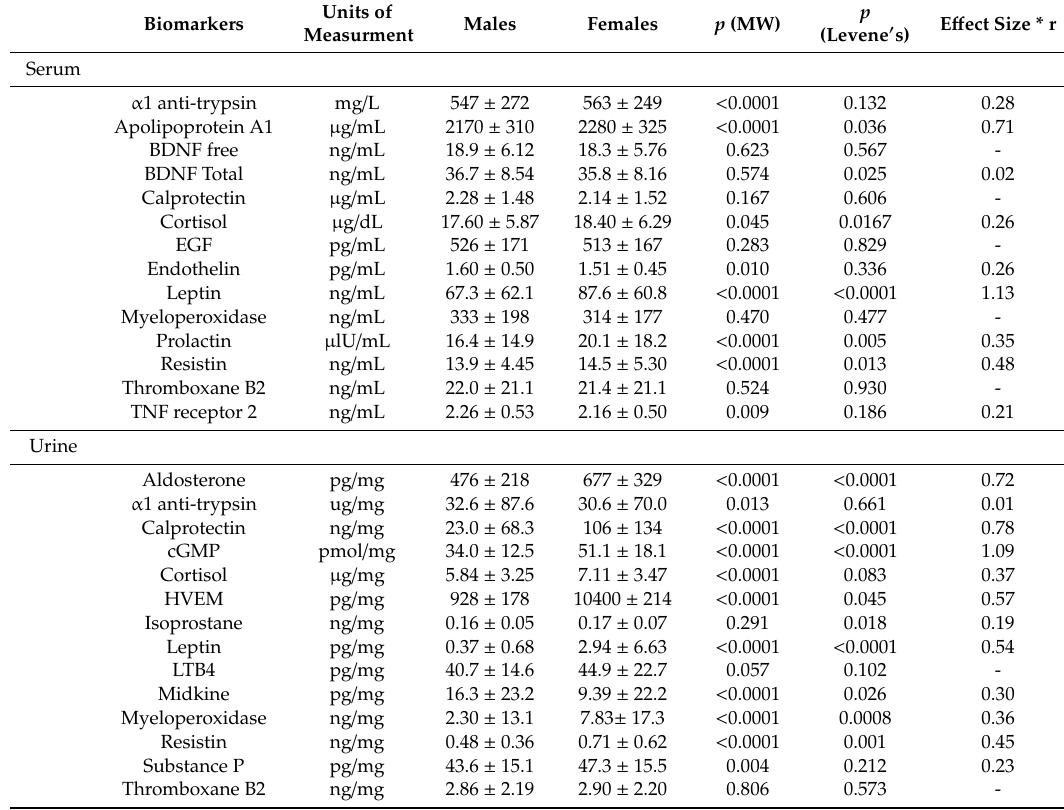
p (Levene (cid:48) s)